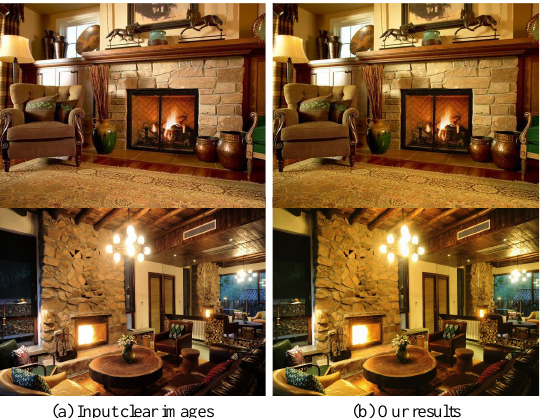
Figure 8. Examples for haze-free scenarios enhancement. ( a ): haze-free real photos with fire and. ( b ):enhancement results by